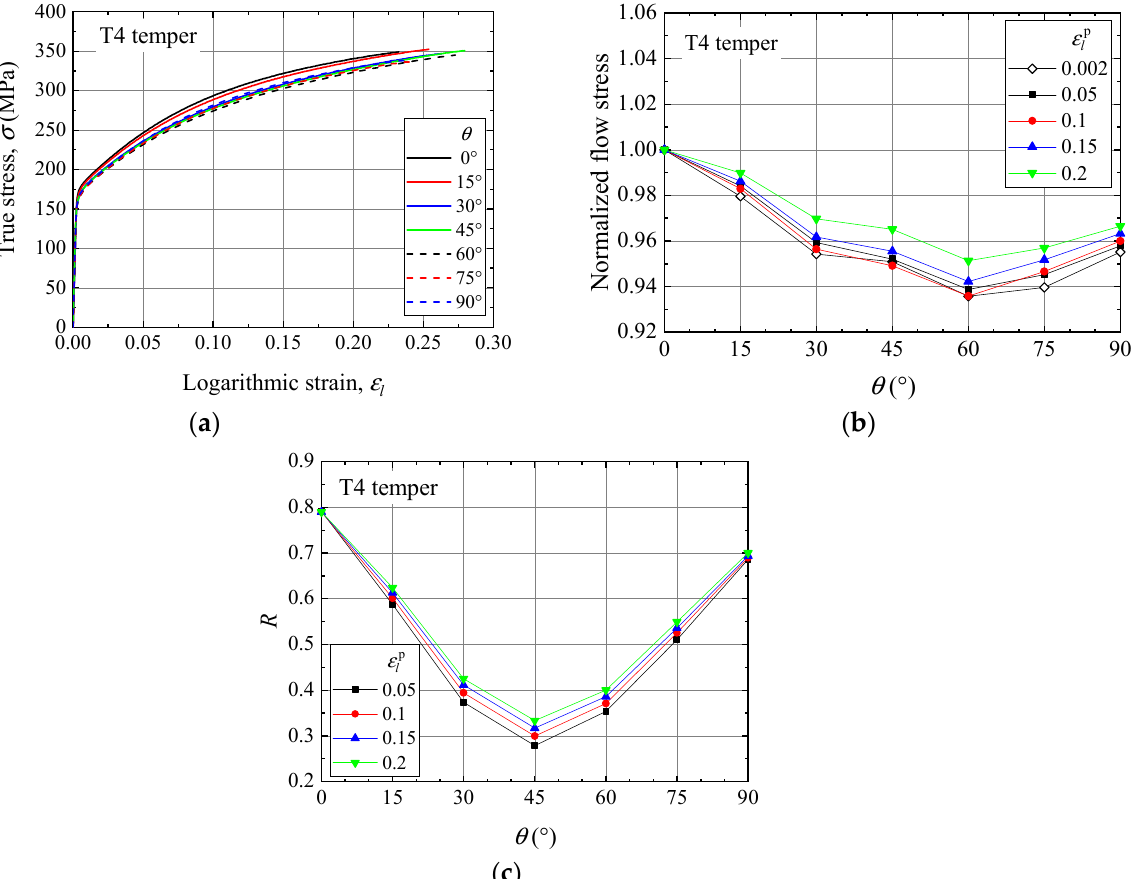
Figure 2. Results of uniaxial tension for T4 temper sheet. ( a ) True stress–logarithmic strain curve; ( b ) Normalized flow stress; and ( c ) R value.